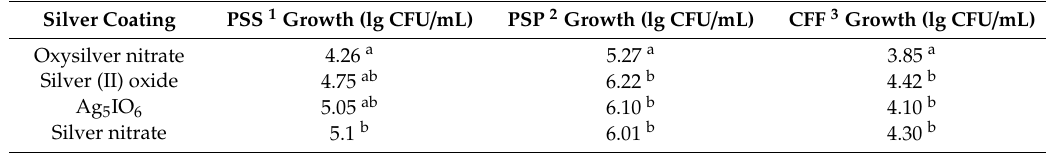
Table 2. Mean lg CFU / mL values for three bacterial blight pathogens on seeds with one of each of four silver coatings. Means that do not share a letter in common are statistically significantly di ff erent according to Tukey’s pairwise comparison at p ≤